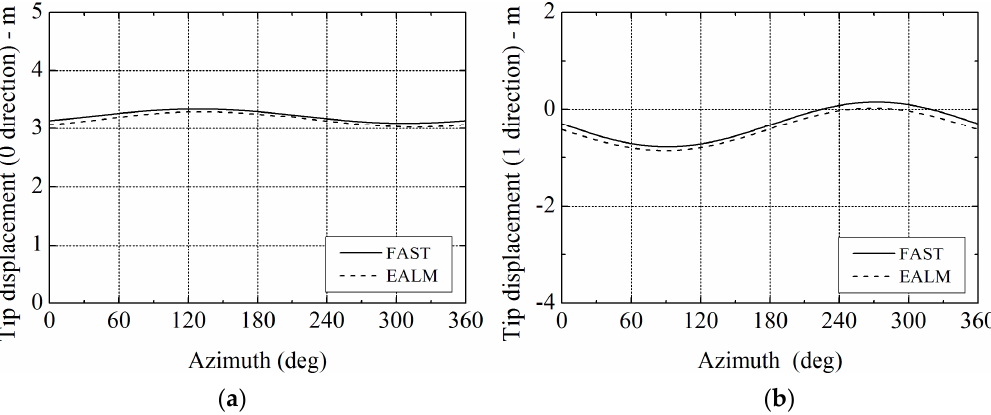
Figure 15. Comparison of azimuthal variations of blade tip deformations between elastic actuator line model (EALM) and NREL’s FAST code at 8 m/s: ( a ) in 0 direction; and ( b ) in 1 direction.